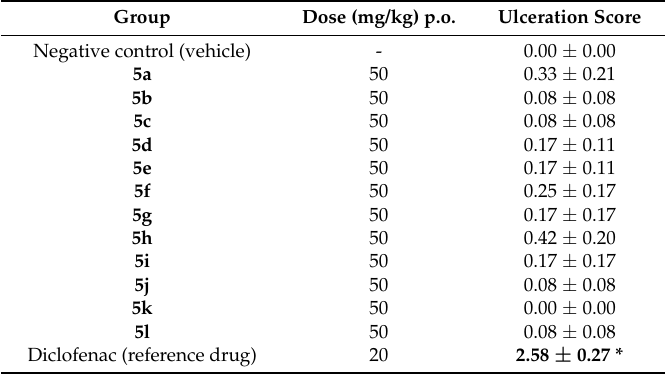
Table 3. Ulcerogenic activity screening of the synthesized compounds. Group Dose (mg/kg)